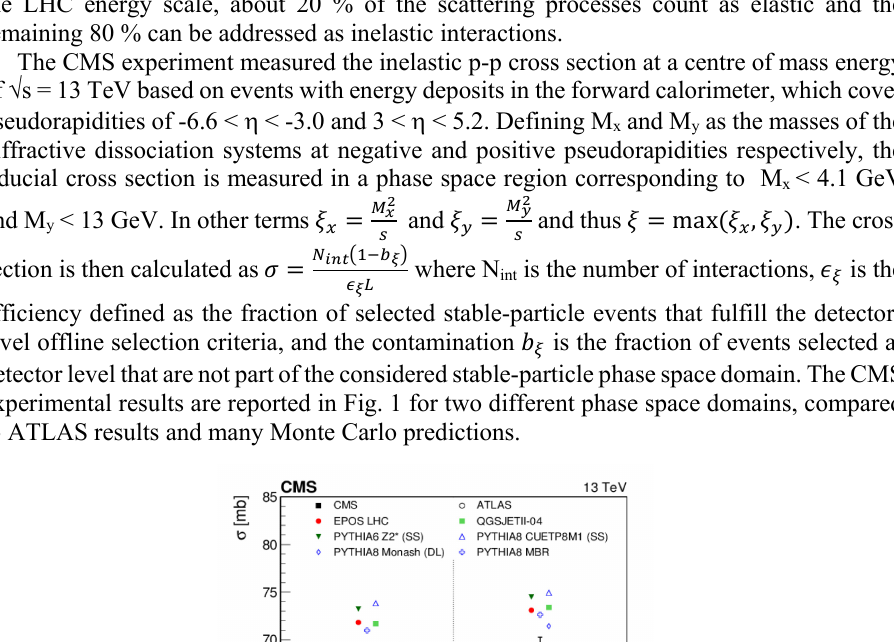
Fig. 1. Proton-proton inelastic cross section at √s=13 TeV in two phase space regions, where compared to different models and to the ATLAS result